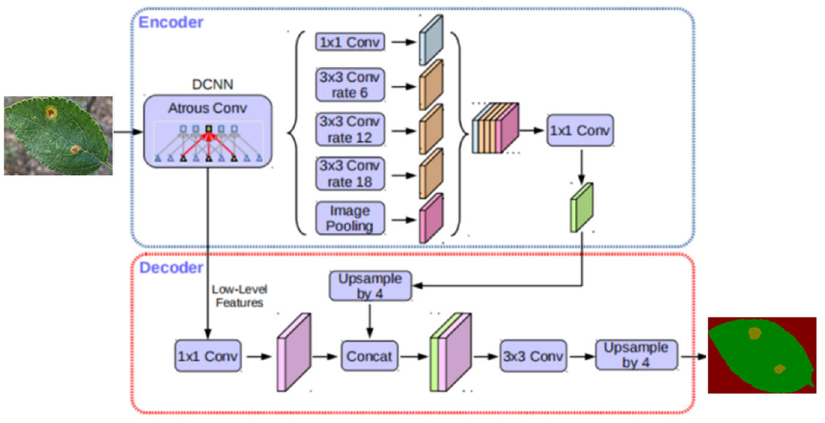
Figure 3. Schematic diagram of the overall structure of the